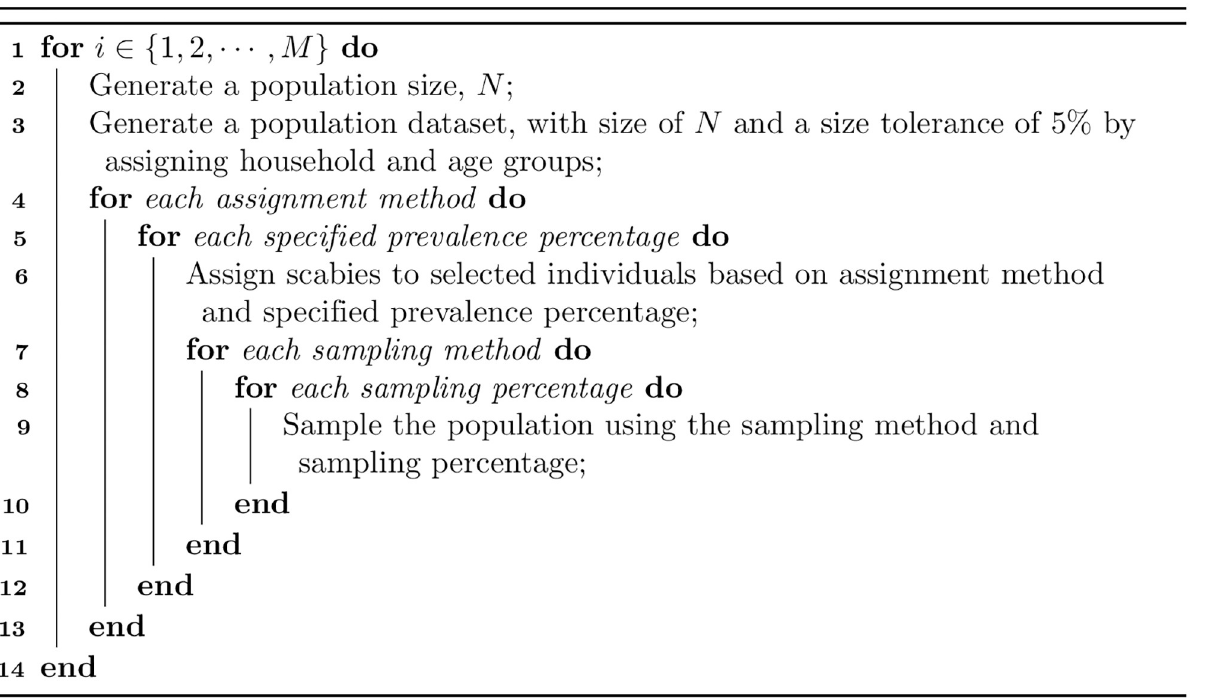
Fig 3. Pseudo code of our algorithm.